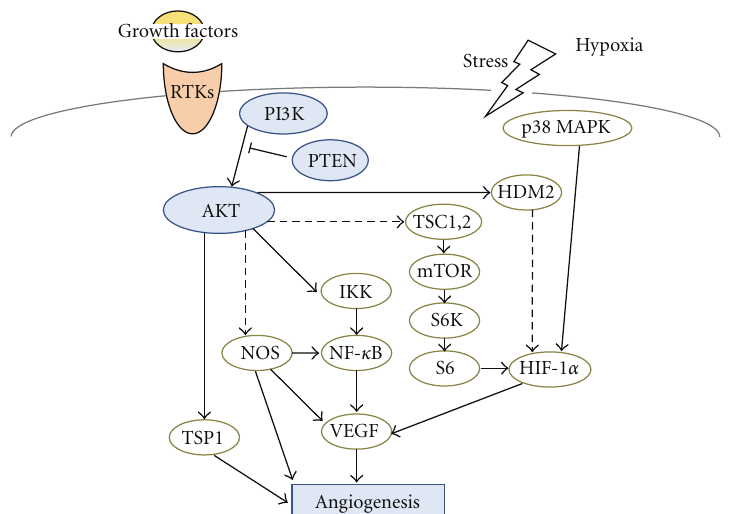
Figure 1: Schematic representation of PI3K/AKT/PTEN signaling. Examples of molecules known to act on angiogenesis via PI3K/AKT regulatory pathways are